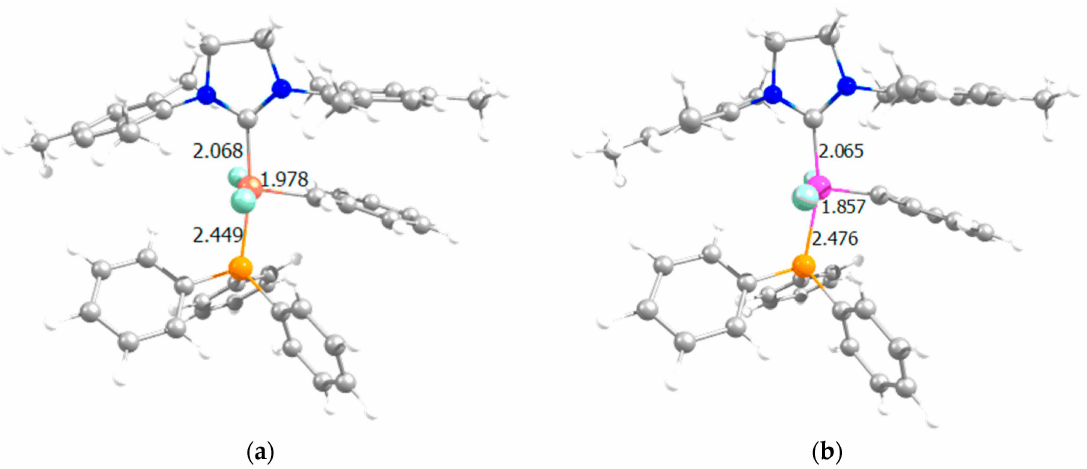
Figure 2. Species I for: ( a ) Rh and ( b ) Ru (selected distances in Å).